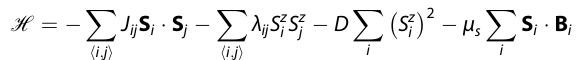
Table 1). All parameters are calculated using strongly correlated density functional theory based on Hubbard- U methods. Supple-